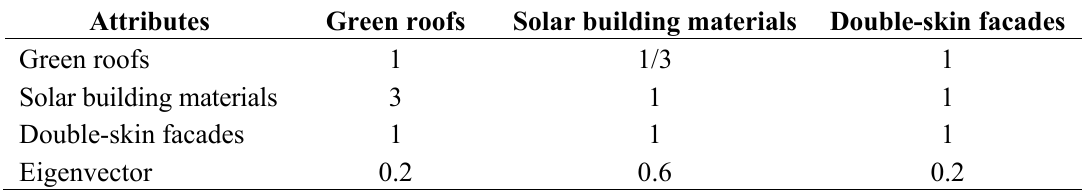
Table 3. Weighting value of building facades: comparison of green roofs, solar building materials, and double-skin facades.